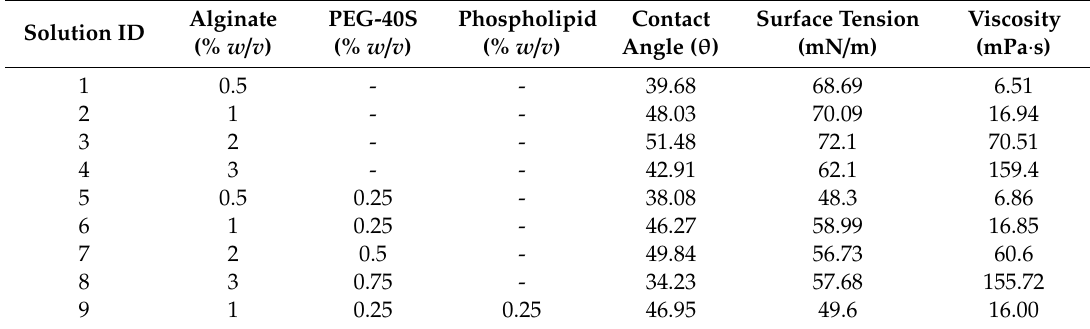
Table 2. Physical properties (e.g., contact angle, surface tension, and viscosity) of the alginate-based polymeric solutions used in order to construct porous film structures in this experimental